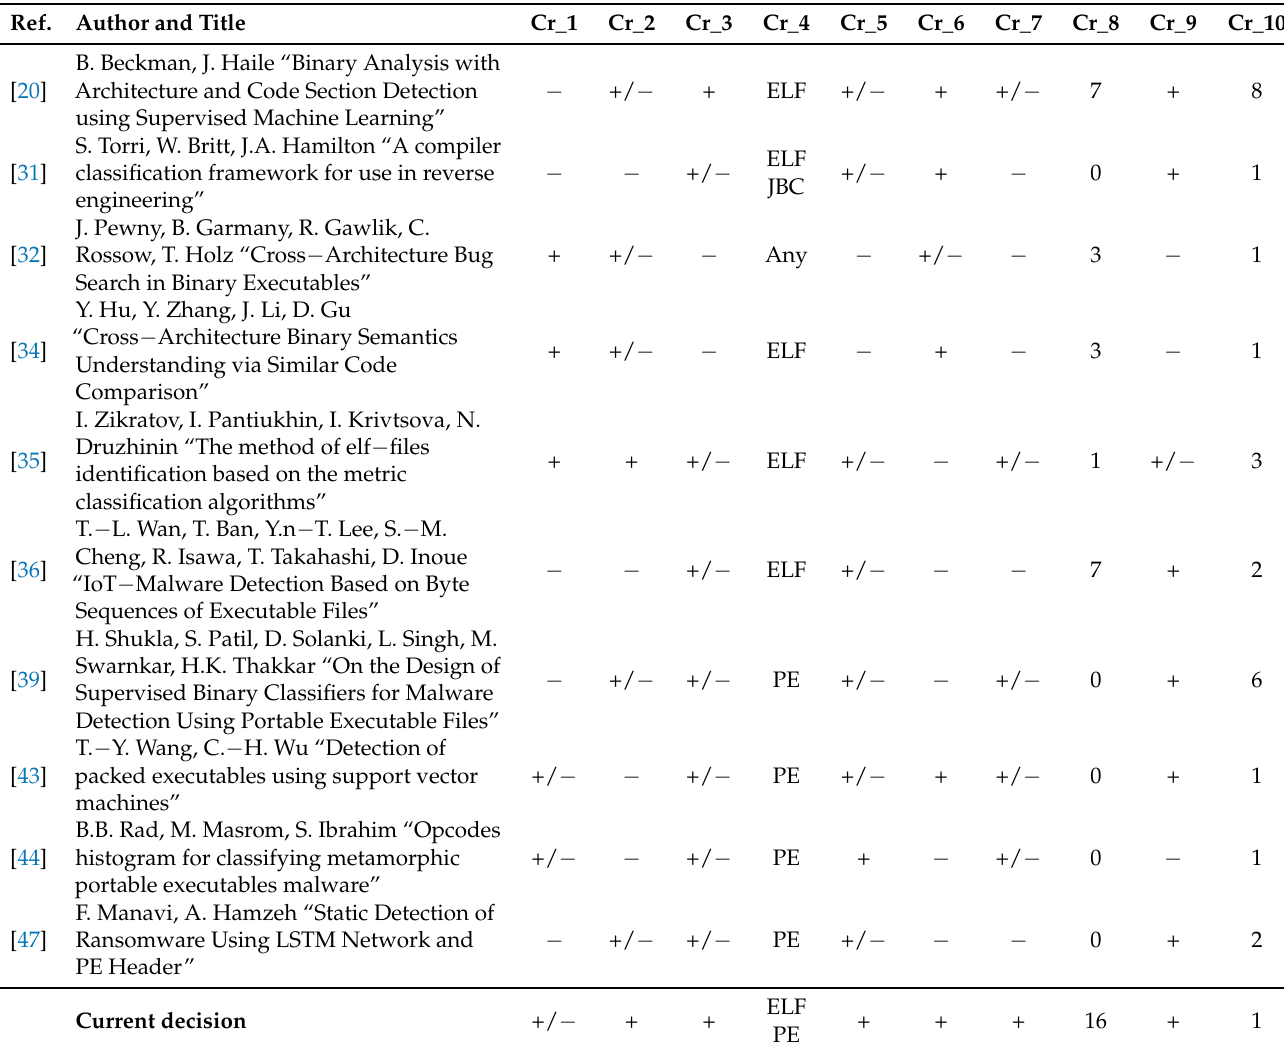
Table 4. Criteria comparison of the proposed Method and Identification Utility with